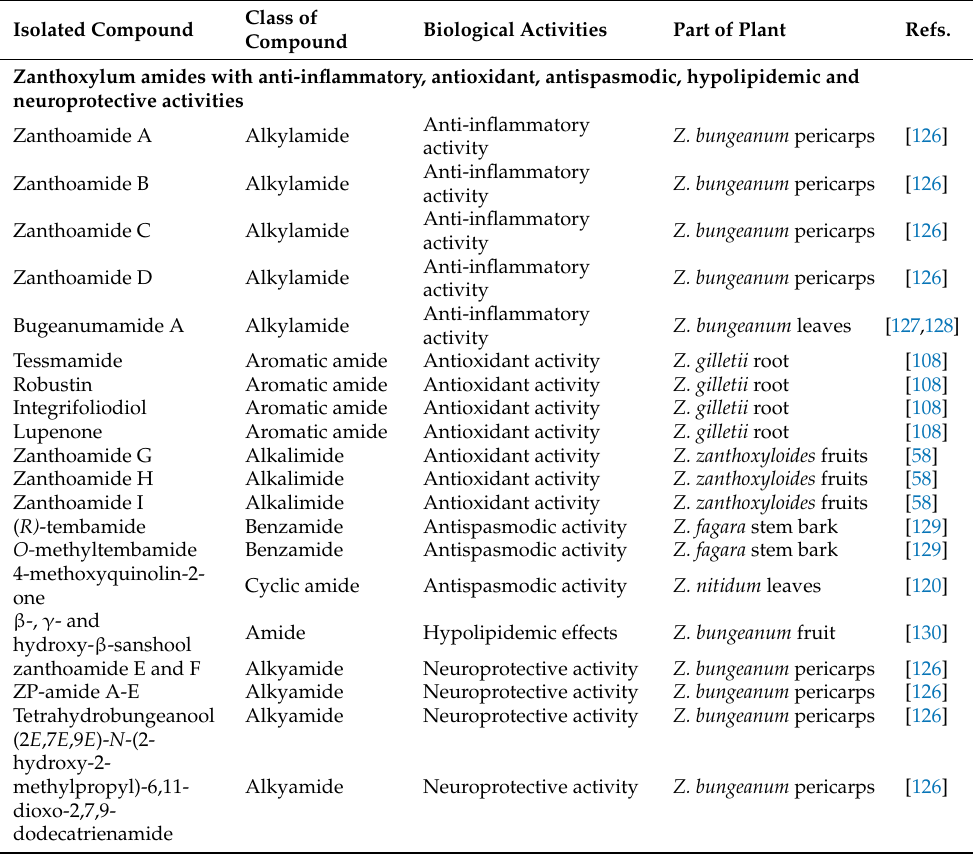
Table 7. Amides isolated from Zanthoxylum species and their biological activities. Isolated